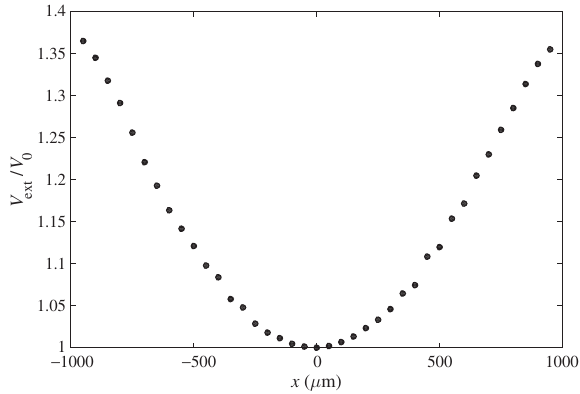
FIG. 7. Approximate external potential for particles in colloidal experiments. Using the geometry of the experimental setup, the radial electric field profile is numerically calculated and used to model the external potential felt by the particles V Note that the particles in the experiment are confined to a radius R < 500 μ m.